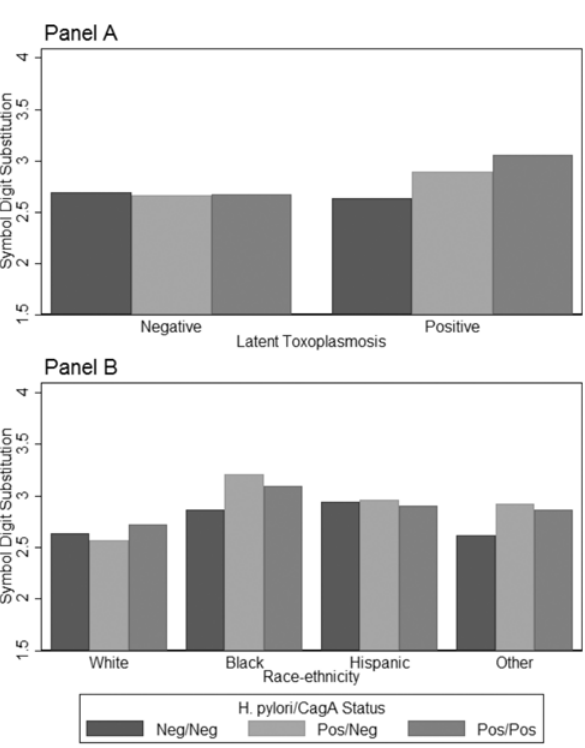
Figure 1. Model-based Predictions of the Symbol Digit Substitution Test Illustrating the Interaction of Latent Toxoplasmosis and Race-ethnicity with H. pylori and CagA. Panel A presents model-based predictions (Table 4, Model 1) of the interaction of latent toxoplasmosis with H. pylori and CagA on the Symbol Digit Substitution Test (SDS) controlling for age, gender, race-ethnicity, PIR, education, health, and hemoglobin. Higher SDS values indicate poorer cognitive function. Panel B presents model-based predictions (Table 4, Model 3) of the interaction of race-ethnicity with H. pylori and CagA on the Symbol Digit Substitution Test (SDS) controlling for latent toxoplasmosis, age, gender, PIR, education, health, and hemoglobin. Higher SDS values indicate poorer cognitive